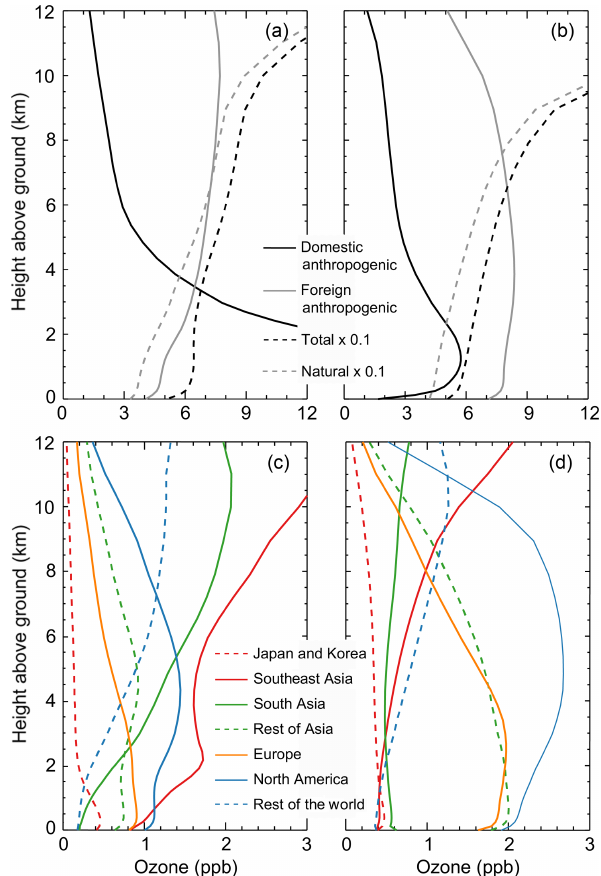
Figure 14. (a) Vertical distribution of regional average daily mean ozone contributed by domestic anthropogenic emissions, foreign anthropogenic emissions, natural sources (scaled by 0.1), and total sources (scaled by 0.1) over regions where Chinese anthropogenic emissions contribute more surface ozone than total foreign anthro- pogenic emissions. (c) Contribution by anthropogenic emissions of each foreign source region over regions where Chinese anthro- pogenic emissions contribute more surface ozone than total foreign anthropogenic emissions. (b, d) Similar to (a, c) but for regional av- erage daily mean ozone over regions where foreign anthropogenic emissions dominate. The linear weighting adjustment is applied to derive all